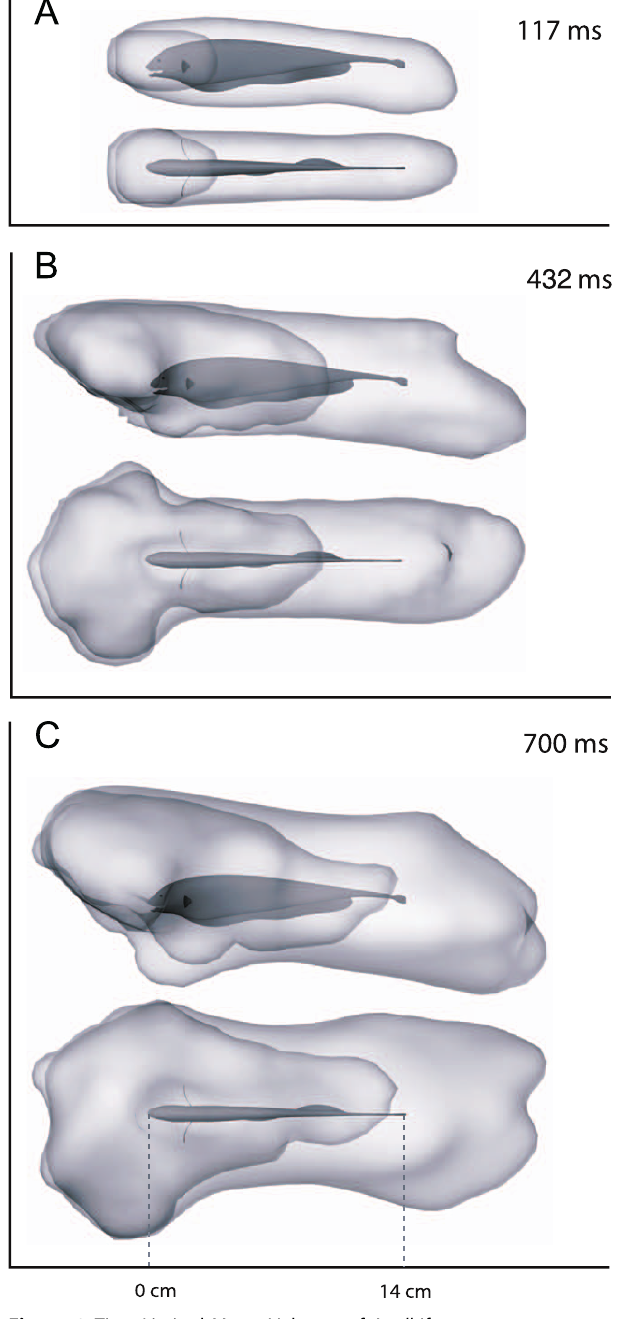
Figure 6. Time-Limited Motor Volumes of A. albifrons The motor volumes are shown for both the entire electrosensory array MV body and for the mouth alone MV mouth for three time intervals. The darker gray mouth volume is fully contained within the lighter gray body volume. (A) Side and top views at 117 ms. (B) 432 ms. (C) 700 ms. Interactive 3-D version for (A), (B), and (C) are available as Figures S2, S3, and S5, respectively.